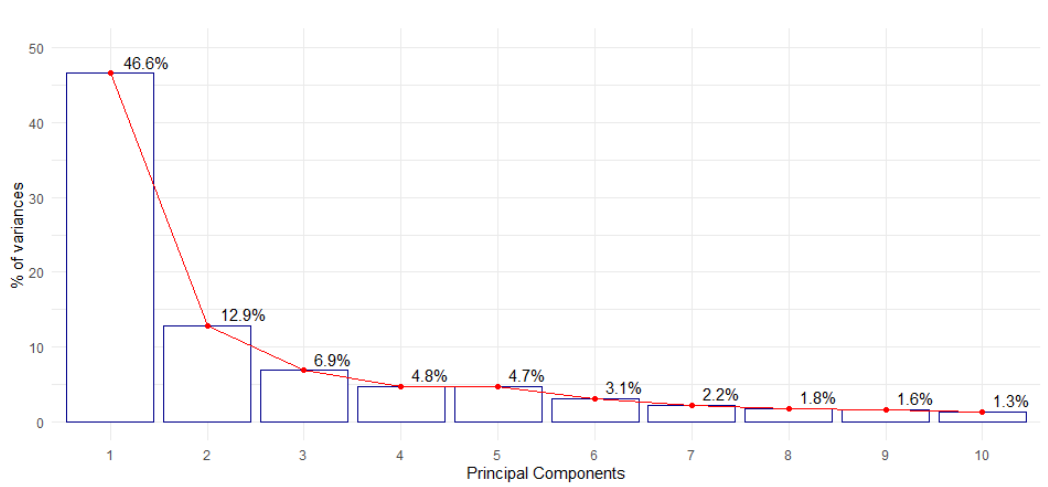
Figure 9. Total variance explained by each principal component